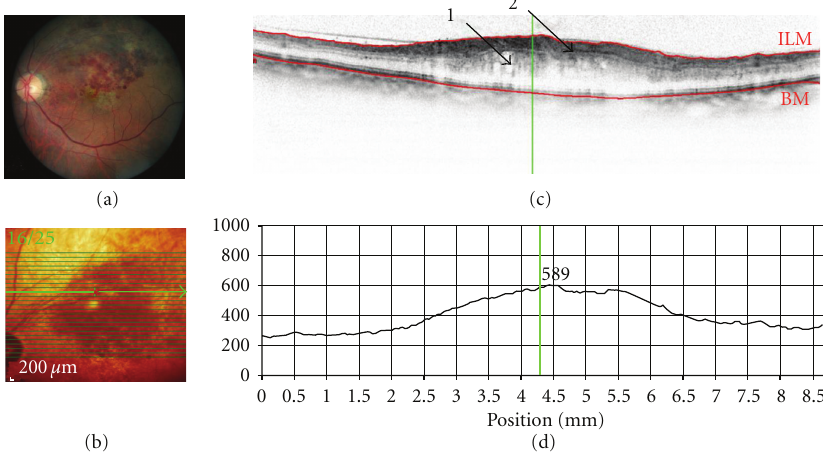
Figure 5: SD-OCT of a patient with branch retinal vein occlusion (OS). Scan parameters: infrared scan angle 30 ◦ ; OCT scan angle 30 ◦ ; pattern size 30 ◦ × 20 ◦ , 25 sections (243 µ m between B-scans). (a) The conventional fundus camera imaging revealed numerous hemorrhages and edema in the superior temporal retina with macular involvement. The macula was yellow and edematous. (b) SD-OCT en-face image of the fundus (note that the cross-sectional image is located approximately 5 ◦ superior to the superior ONH margin). The green arrow shows the position of the scan line used to generate the cross-sectional retinal OCT image (i.e., (c)). (c) The cross-sectional retinal image showed retinal edema with fluid cysts in the outer retina (arrow “1”) and an apparently thickened inner retina with superficial hemorrhages (arrow “2”) which “shadow” the underlying retinal details. (d) The lower red segment line (shown in (c)) fails to fit the true position of Bruch’s membrane; the line was positioned based on visible parts of Bruch’s membrane. The cross-sectional retinal thickness profile revealed a markedly thickened retina in the center of the BRVO (retinal thickness is close to 600 µ